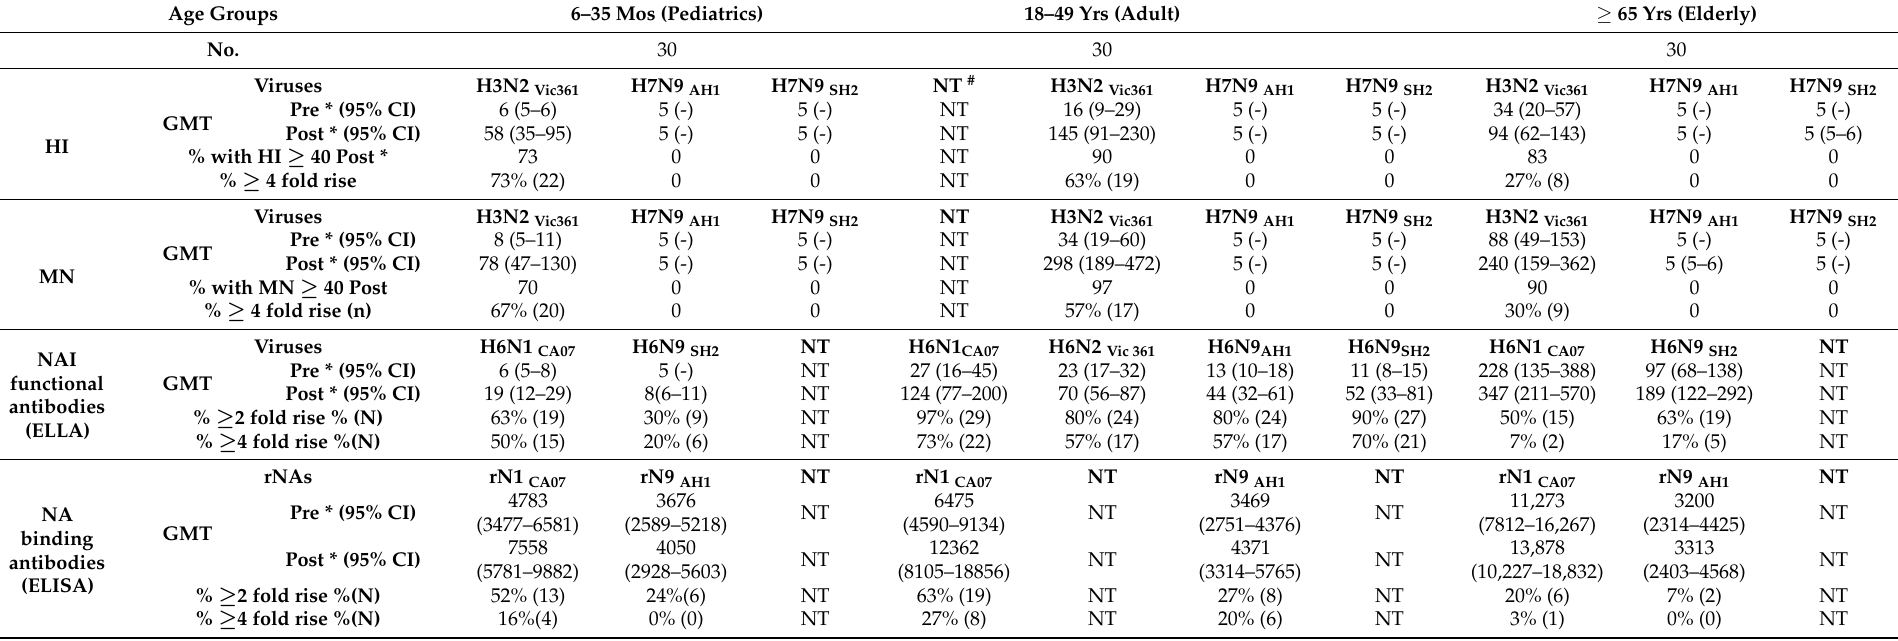
Table 3. HI, MN, NAI and NA binding antibody responses to A(H7N9) following seasonal IIV3 vaccination in children, adults and